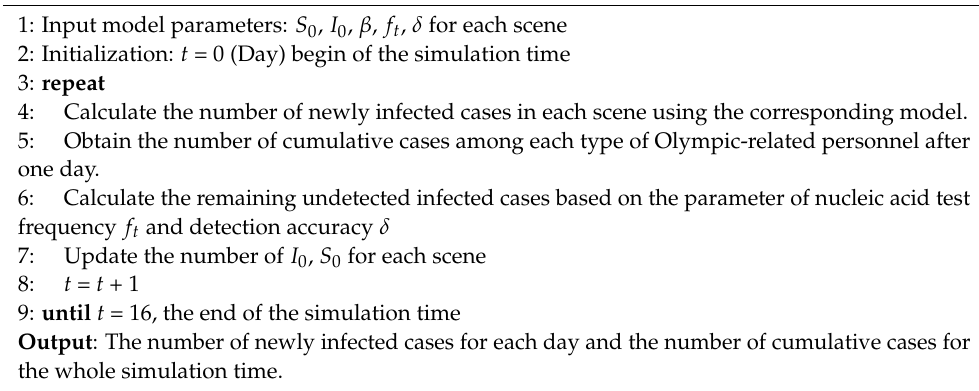
Algorithm 1. Simulation procedure for the Olympic-related personnel